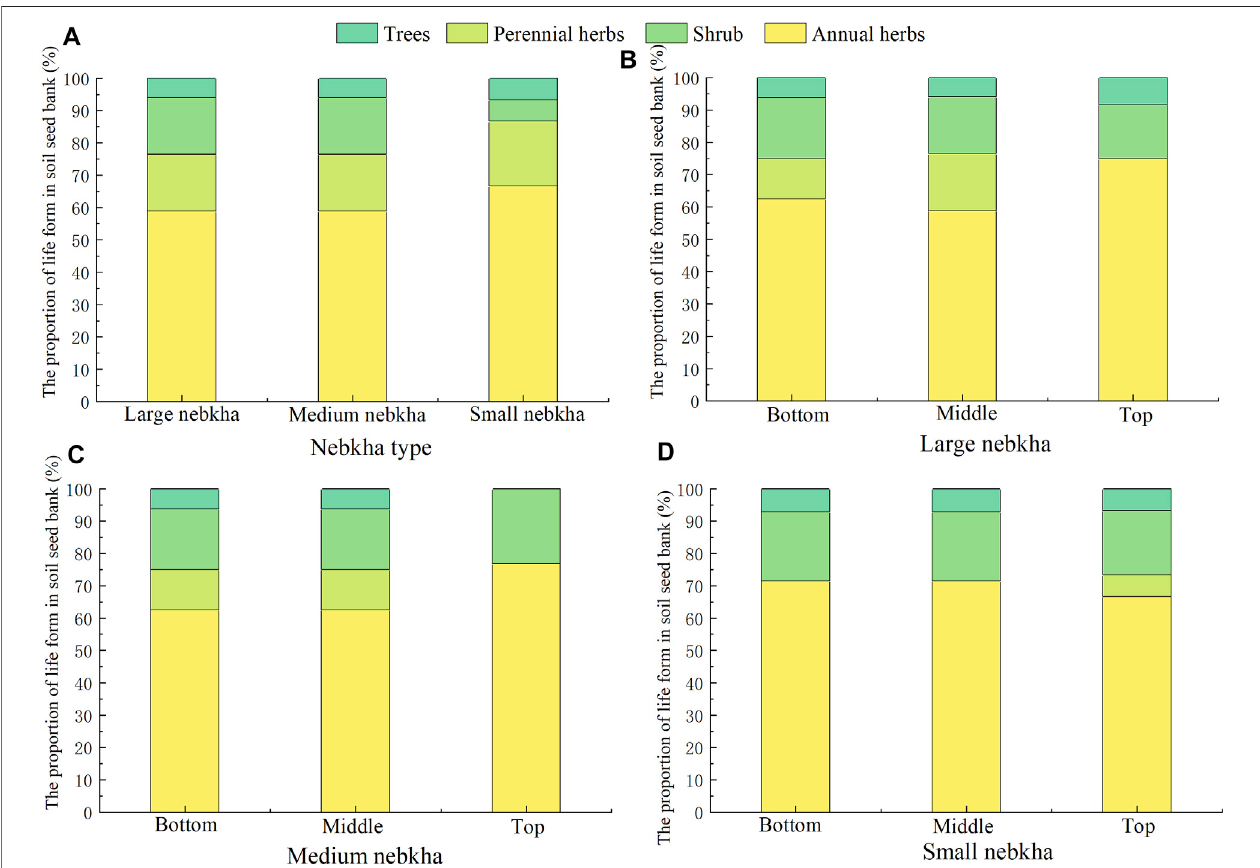
FIGURE2| LifeformsofsoilseedbanksinNitrariatangutorumnebkhas. (A) Comparison oflifeformsofsoilseedbanksinlarge,mediumand smallnebkha. (B – D) Comparison of the life forms of soil seed banks at the top, middle and bottom of the large, medium and small nebkha.